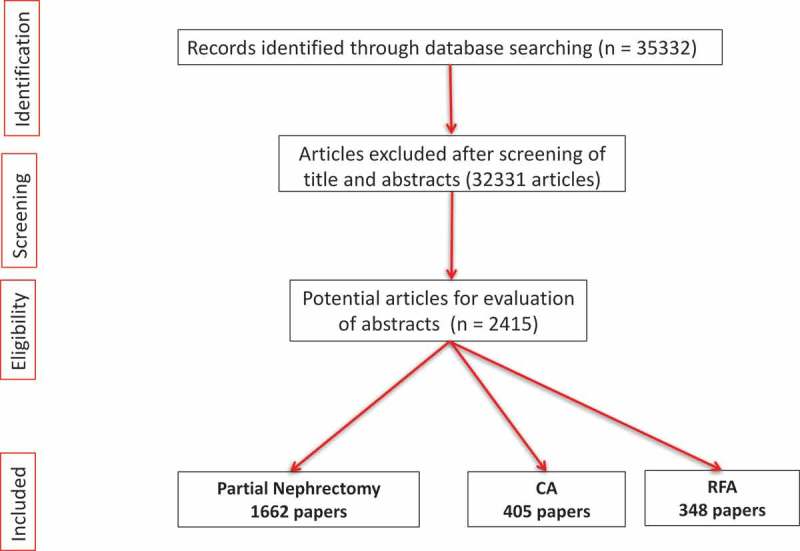
PRISMA flowchart.